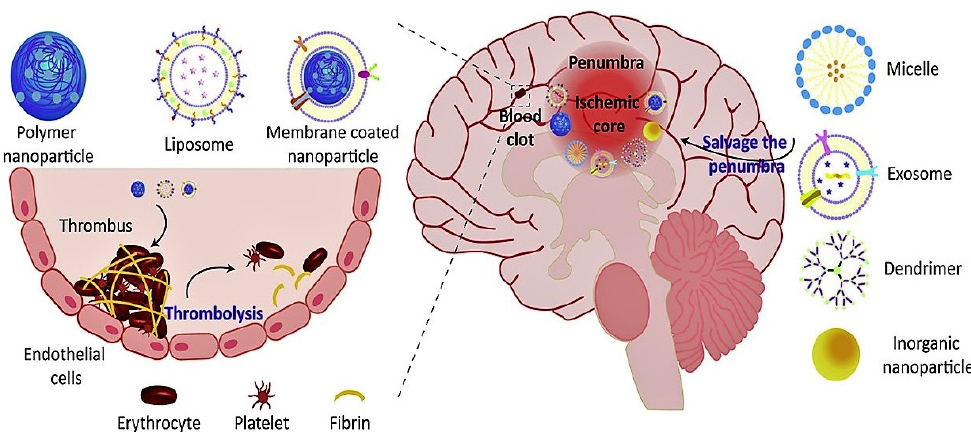
Figure 7. Schematic diagram of different nanomaterials for the treatment of stroke. Adopted from Chao Li et al., 2020 [163].